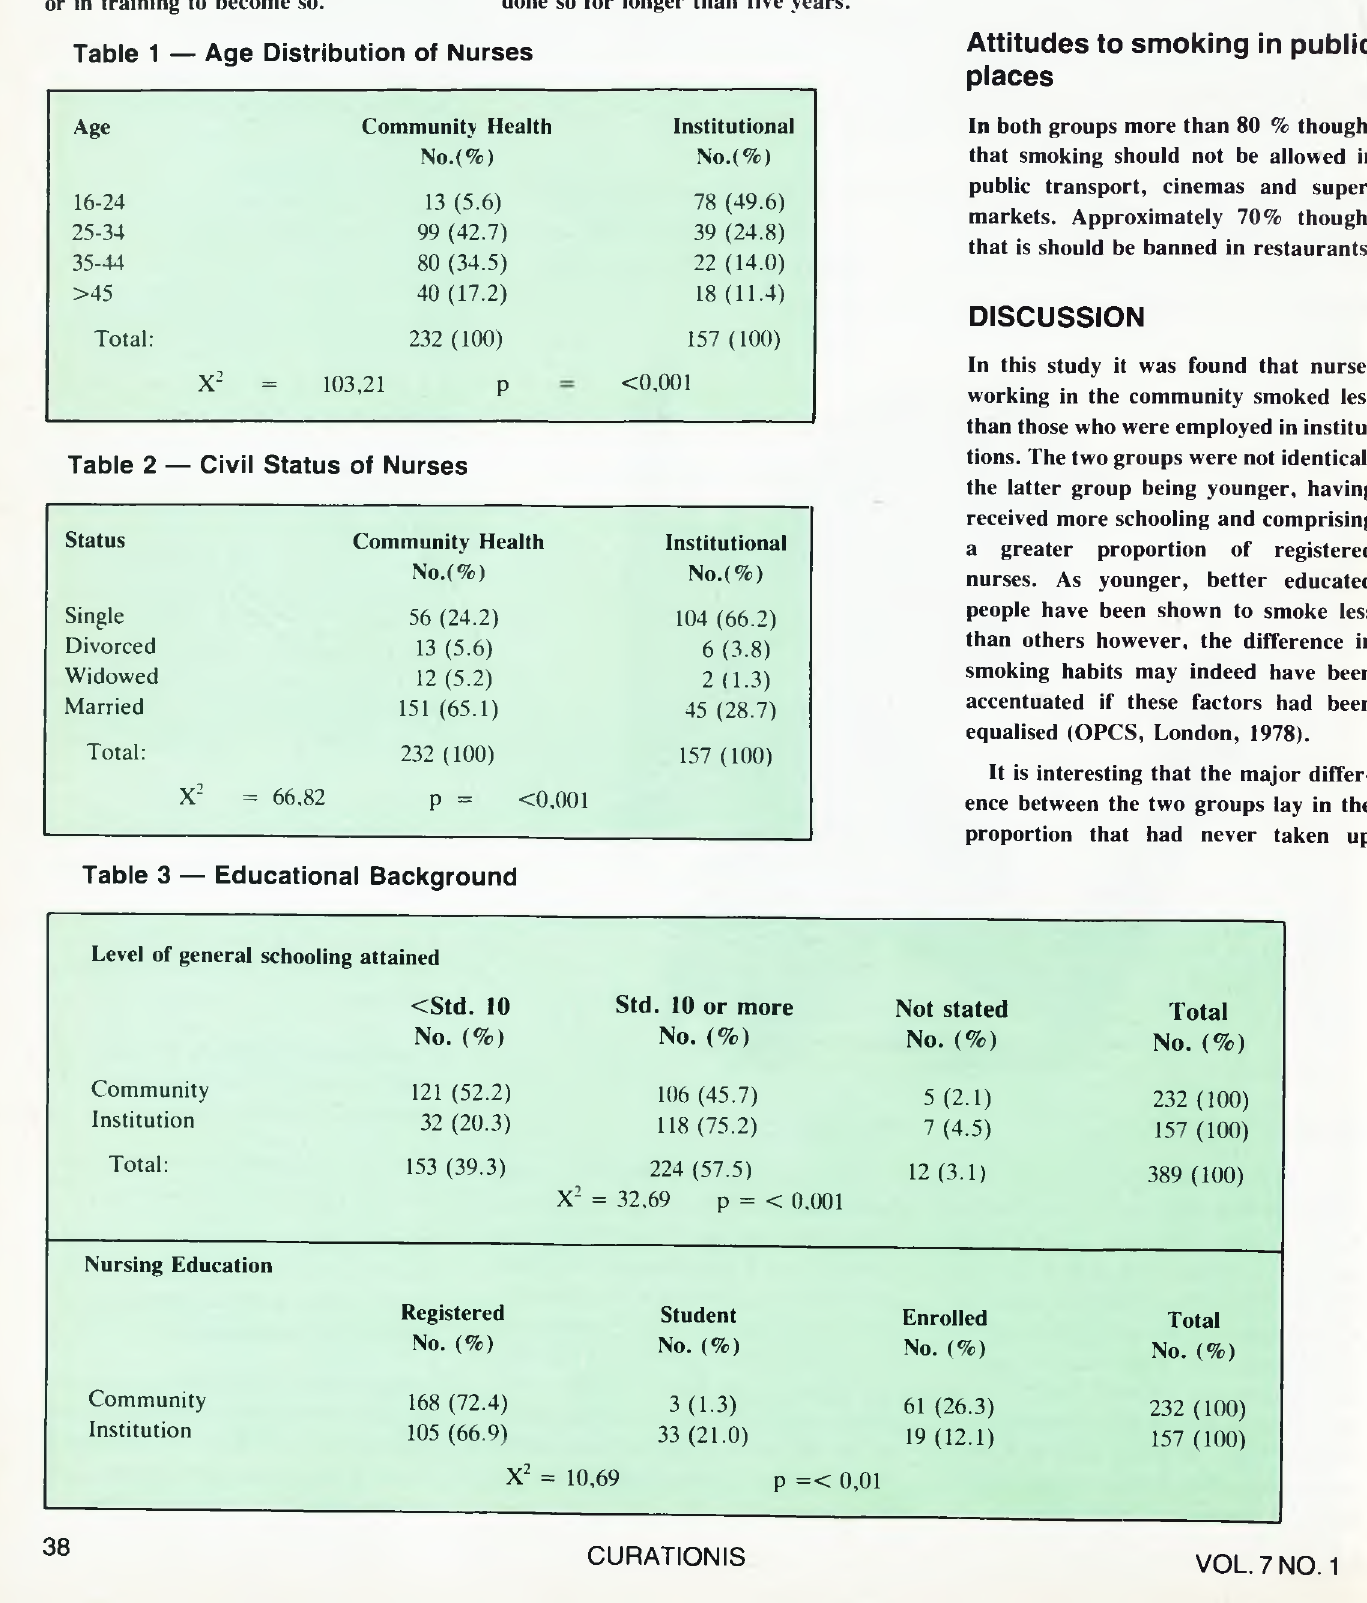
Table 2 — Civil Status of Nurses